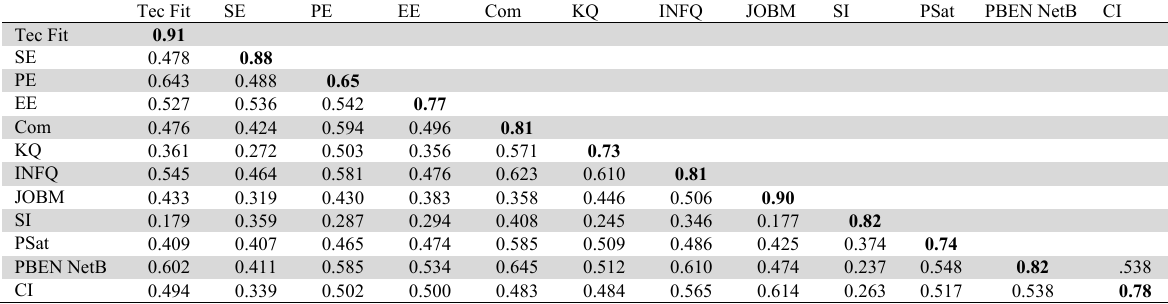
Discriminant validity Statistics for the